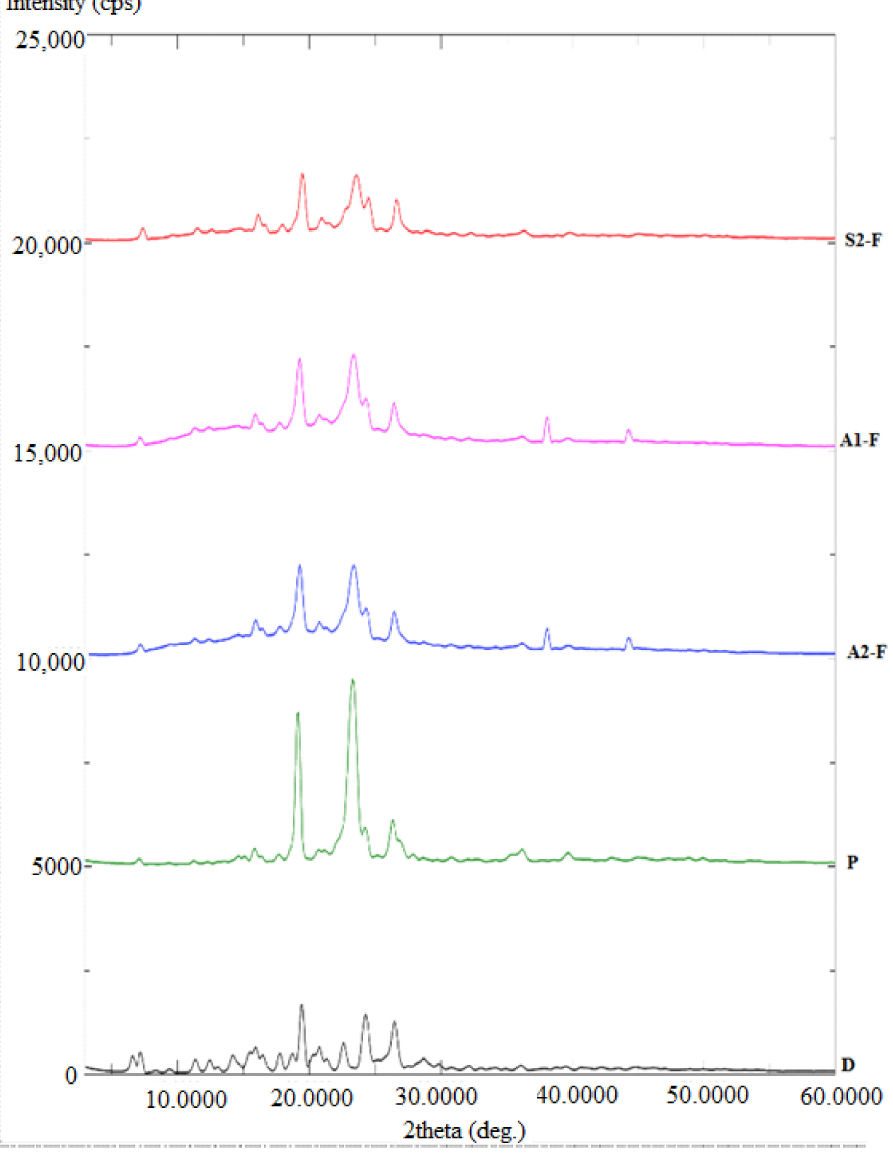
Figure 7. Powder X-ray diffraction (PXRD) spectra for pure Gef and different Gef-SDs formulations prepared using fusion